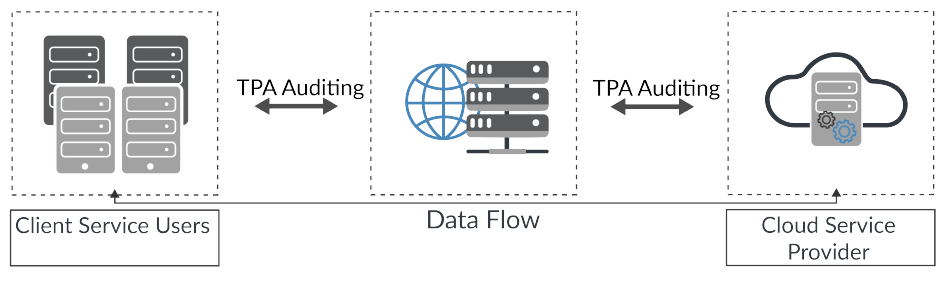
Figure 1. Auditing process based on a